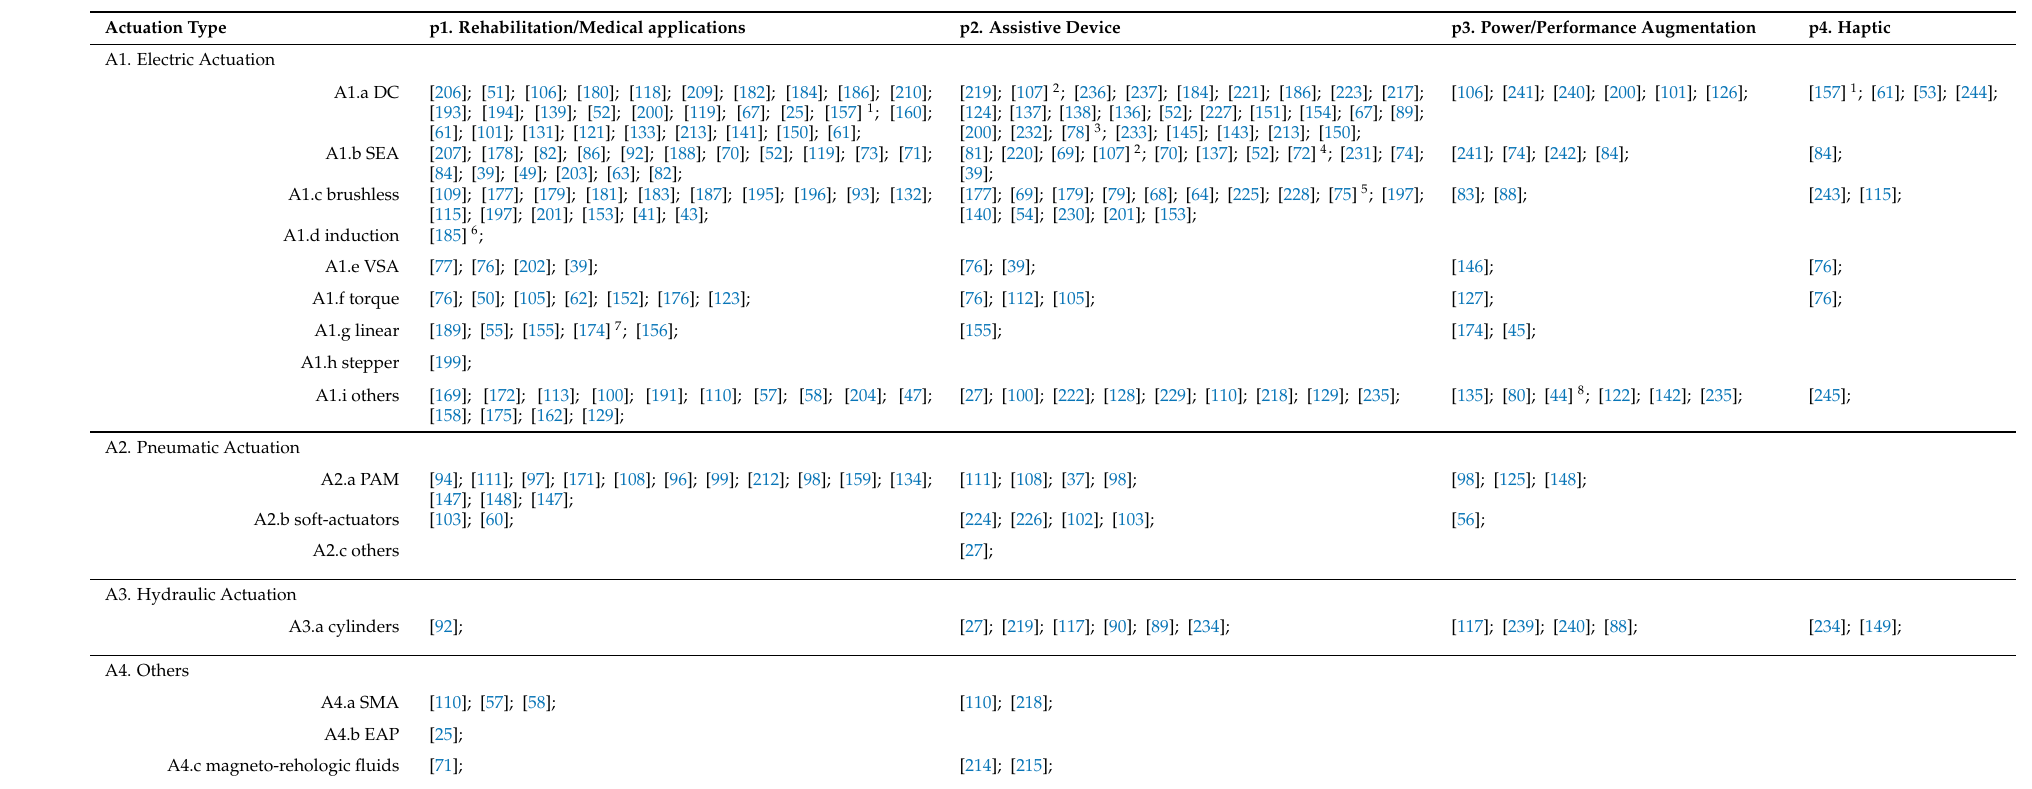
Table A3. Cross analysis of the paper distribution of power source vs. exoskeleton